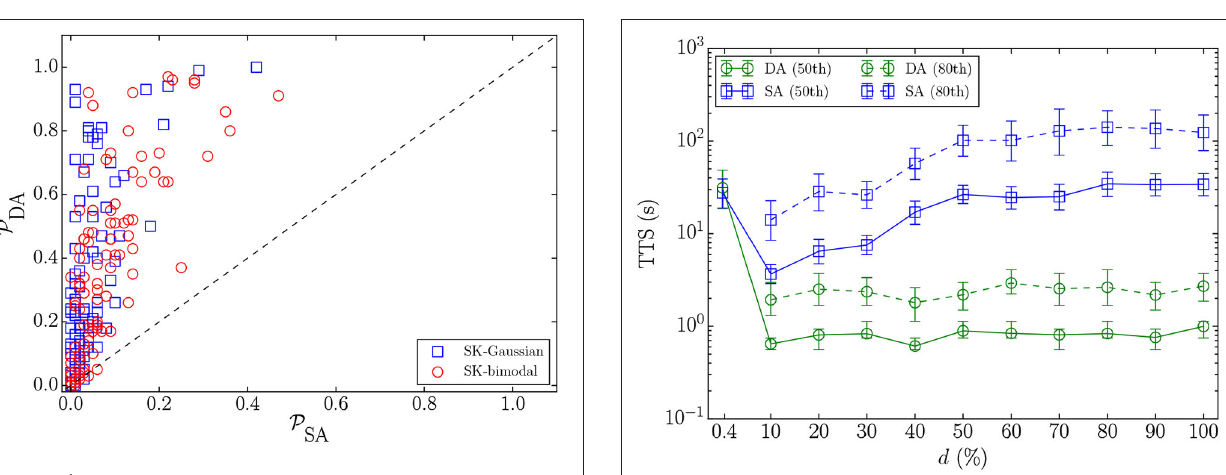
FIGURE 9 | Success probability correlation ( P ) of 100 SK instances of size 1,024 with bimodal and Gaussian disorder. The number of Monte Carlo sweeps in SA is 10 4 and the number of iterations in the DA is 10 7 , corresponding to ≃ 10 4 Monte Carlo sweeps.